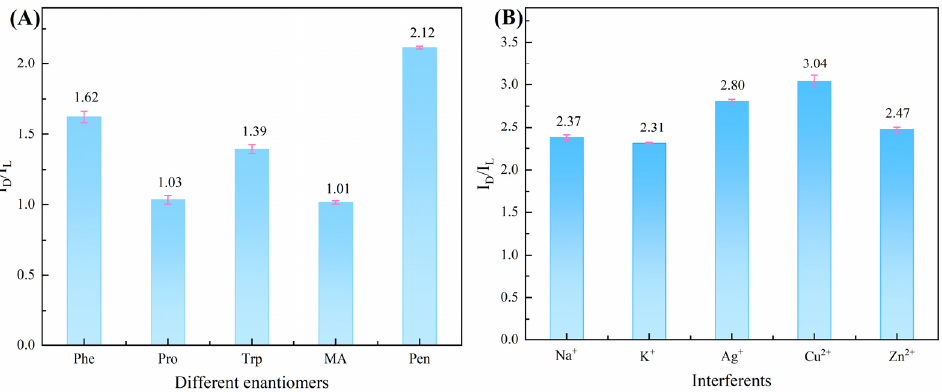
Figure 12. ( A ) Recognition efficiency of 6 mM L, D-phenylalanine (Phe); L, D-proline (Pro); L, D- tryptophan (Trp); and L, D-mandelic acid (MA) using PAA-MWCNTs-Ag-SCS/GCE. ( B ) Chiral recognition of Pen enantiomer in the presence of Na + , K + , Ag + , Cu 2+ , and Zn 2+ (temperature, 25 °C; pH = 7). Error bars represent the standard deviation for three independent measurements.